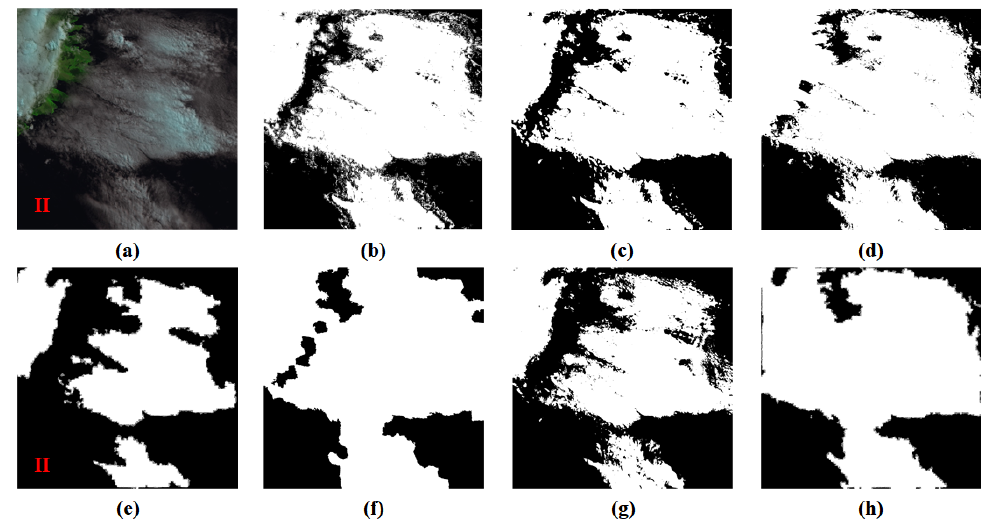
Figure 5. Cloud detection maps of the compared methods: ( a ) Input images labeled II from the Landsat 8 dataset, ( b ) reference detection map, ( c ) proposed, ( d ) K-means, ( e ) PRS, ( f ) PCANet, ( g ) SVM, and ( h ) SL.